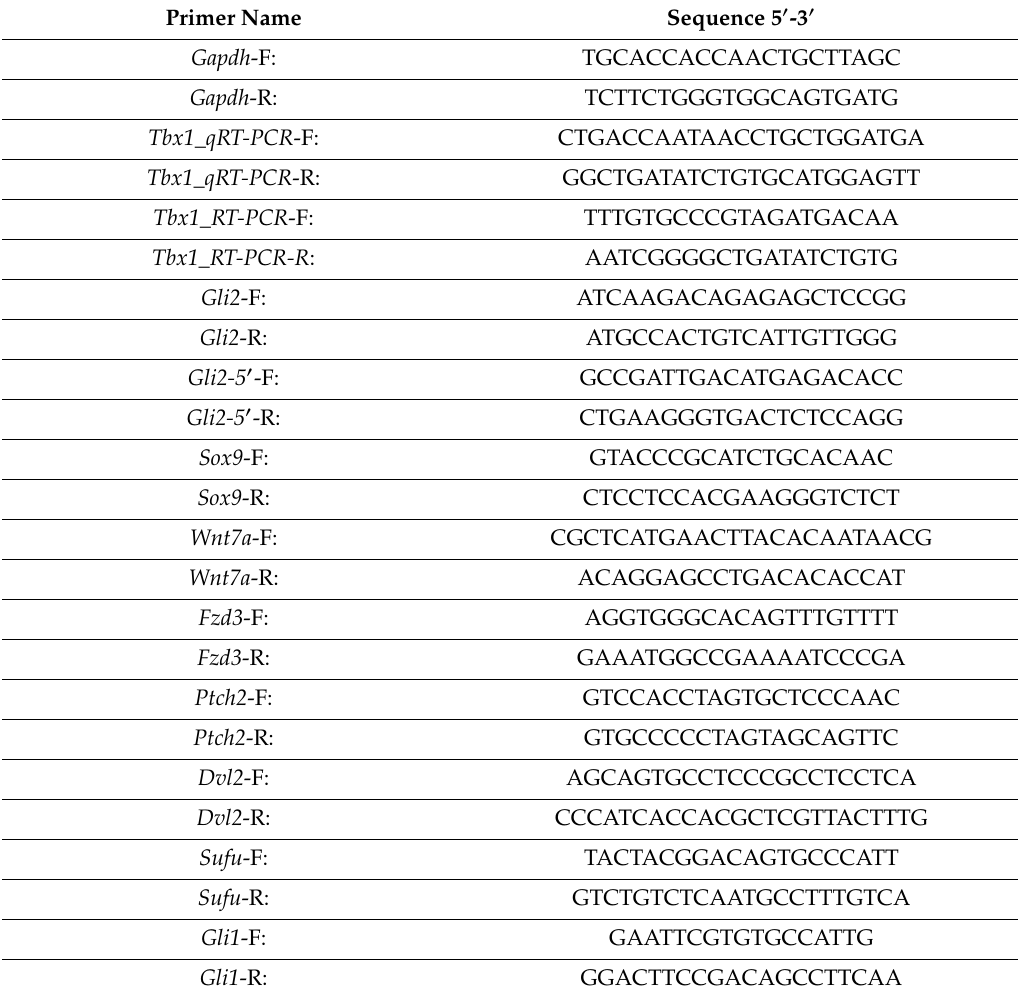
Table 4. Sequence of primer pairs used in this